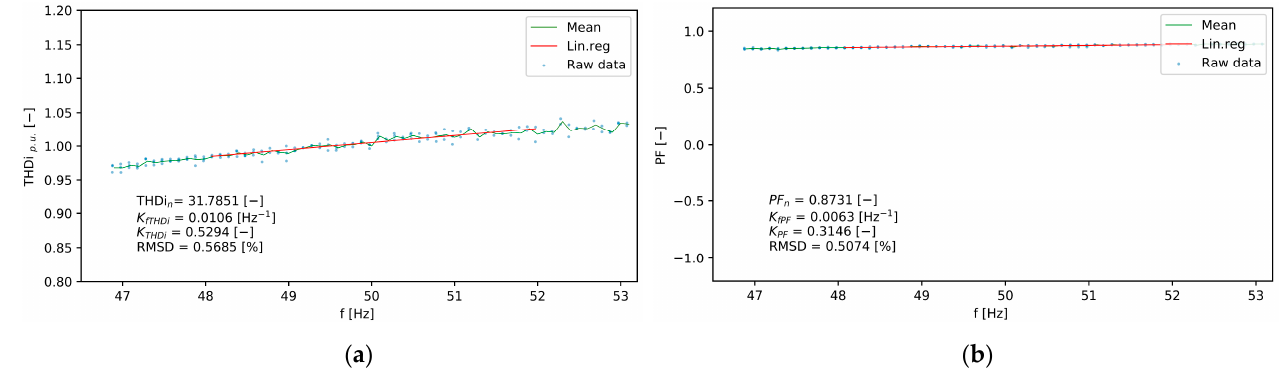
Figure 6. Example of the analyzed characteristics of Wi-Fi router. ( a ) K fTHDi , K THDi ; ( b ) K fPF , K PF .